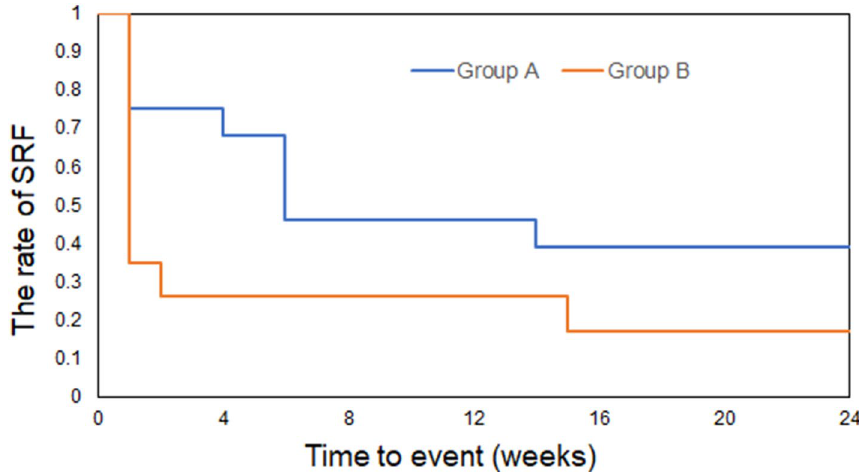
Figure 2. Kaplan–Meier survival curve illustrating the rate of SRF against time for group A (SB without air injection) and group B (SB with air injection). The incidence of SRF was significantly different ( p < 0.001, log- rank test).